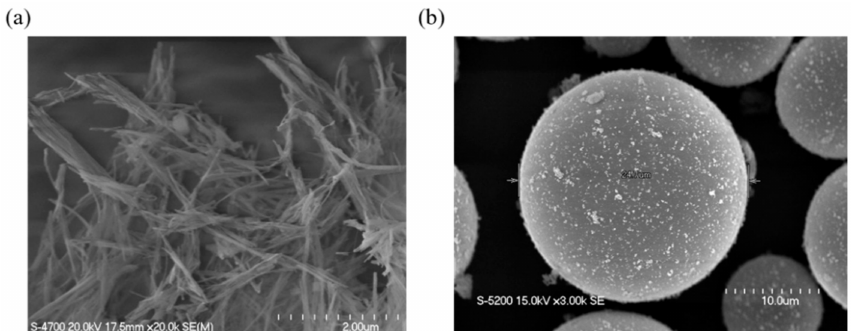
Figure 1. SEM images of ( a ) sepiolite and ( b ) glass microcapsules used in this study.